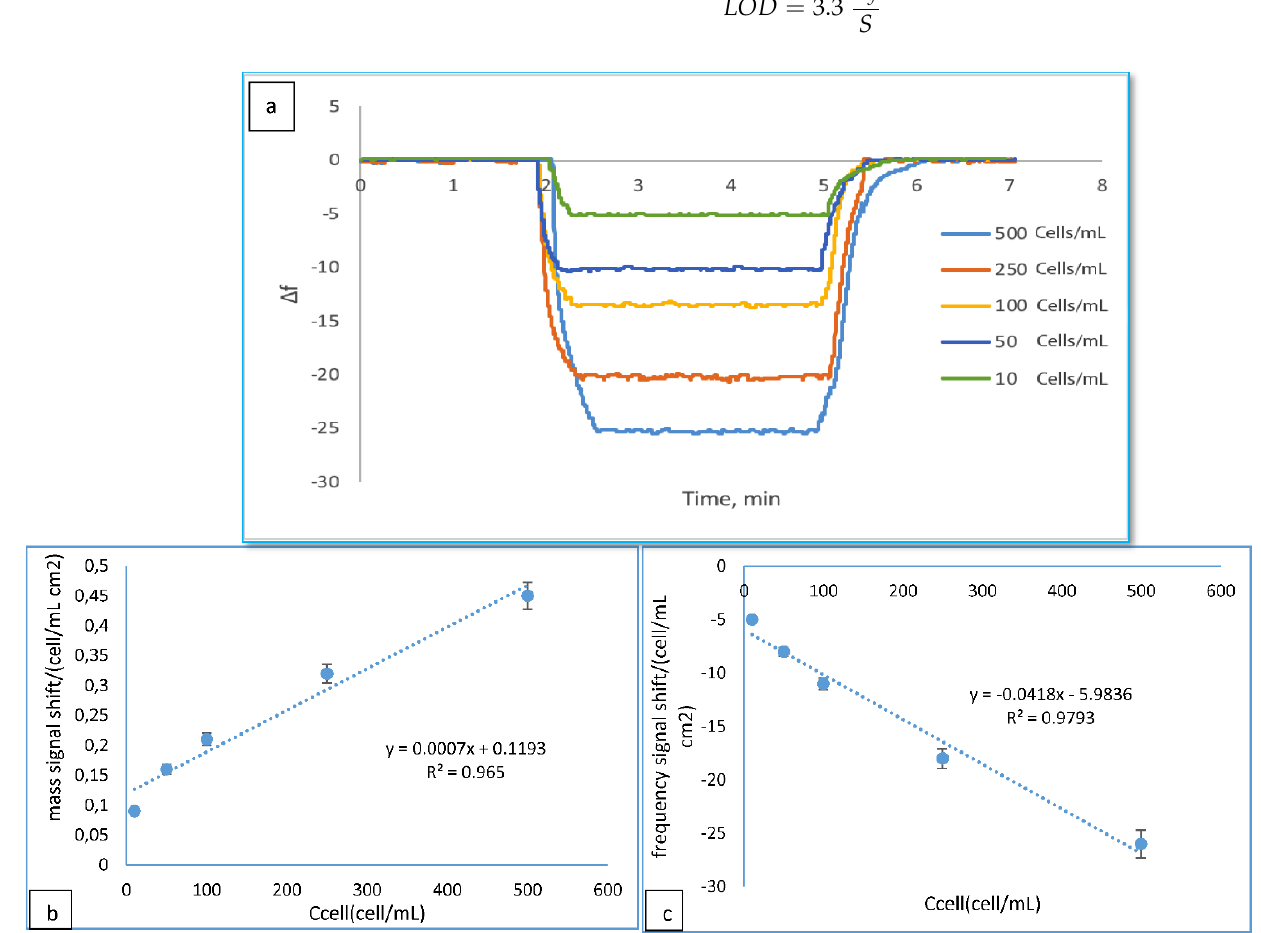
Figure 4. The change in resonance frequency of HER2/neu antibody factionalized QCM sensor by SKBR3 cell binding ( a ), mass signal shift (cell/mL cm 2 ) ( b ) and frequency signal shift (cell/mL cm 2 ) ( c